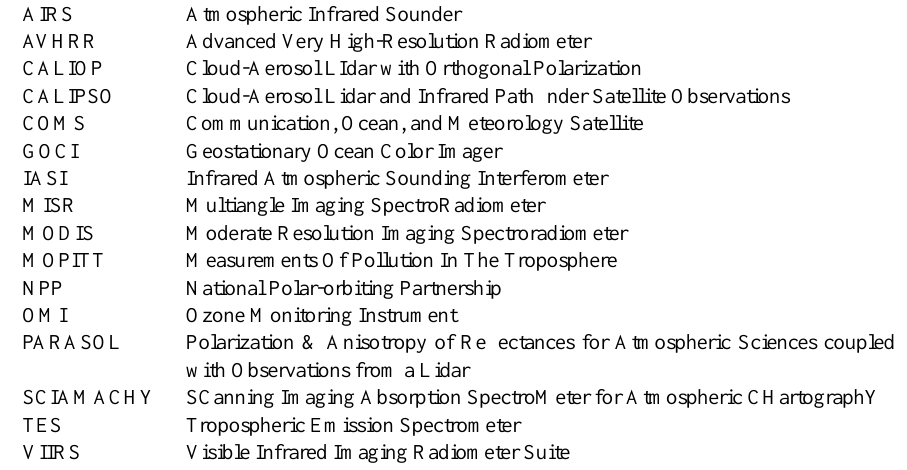
Table 2. Selected list of acronyms.